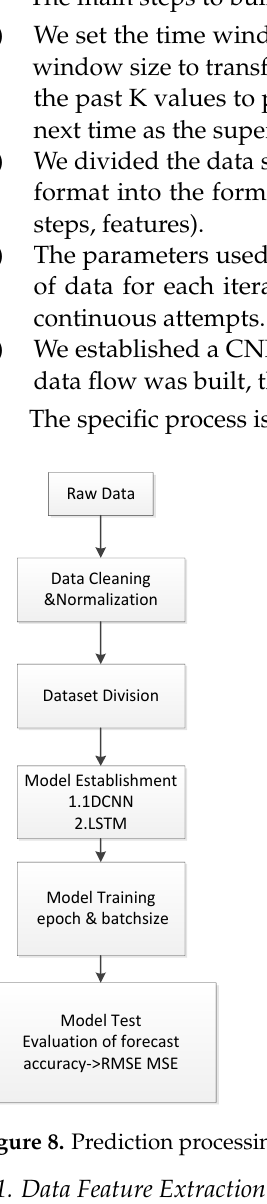
( d ) Initial position curve Figure 9. Data feature curves of pitch axis.